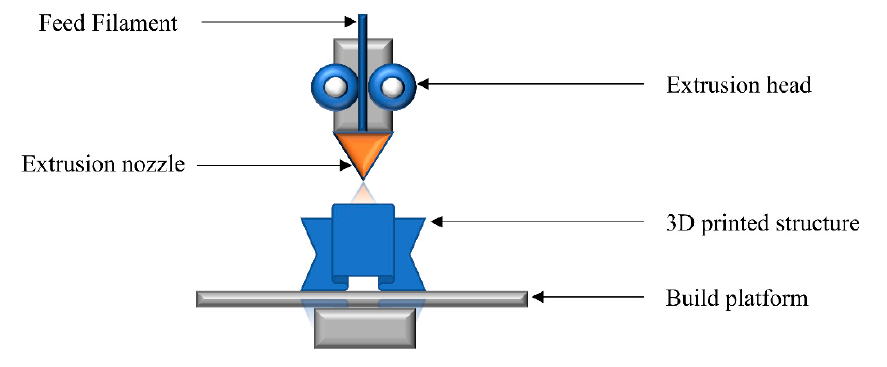
Figure 2. Schematic diagram of the fused filament fabrication (FFF) process. Redrawn from [10,93].